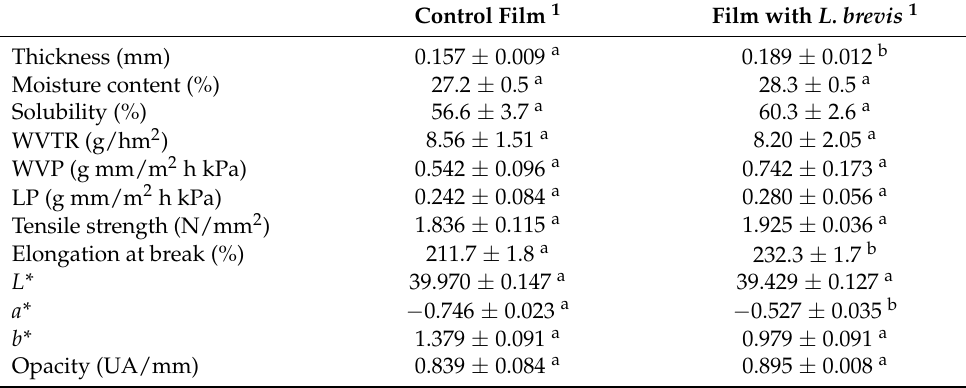
Table 1. Thickness, moisture content, solubility, water vapor transmission rate (WVTR), water vapor permeability (WVP), limonene permeability (LP), tensile strength, elongation at break, color parameters: L* , a* , and b* and opacity of whey–gelatin films without (control) and with L. brevis SJC120. Values are the mean ± SEM ( n = 3). Control Film 1 Film with L. brevis 1 Thickness (mm) Moisture content